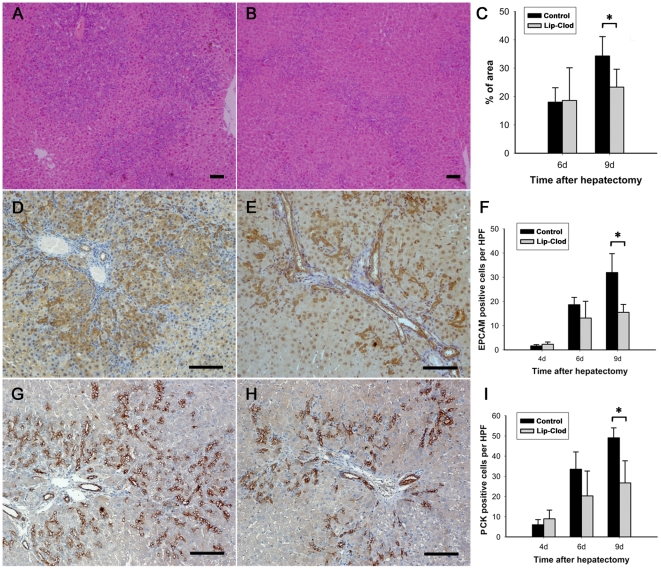
Identification of oval cell expansion in liver sections of 2-AAF/PH rats.A and B: HE staining showing periportal ductular reactions from control (A) and KC depleted rats at day 9 after PH (B) (×40). Comparison of percentage of ductular reaction areas in different groups of animals (C). Data expressed as percentage of ductular reaction area to total area. Immunostaining with antibodies against EPCAM (D and E) and PCK (G and H) in paraffine embedded liver sections from control (D and G) or KC depleted (E and H) rats 9 days after PH (×100). Bar = 100 µm. F and I: Comparison of the number of EPCAM (F) or PCK (I) positive oval cell in different groups of animals. (Data represent mean ± SD, n = 4–5. * indicates significant difference when compared to controls group, P<0.05).